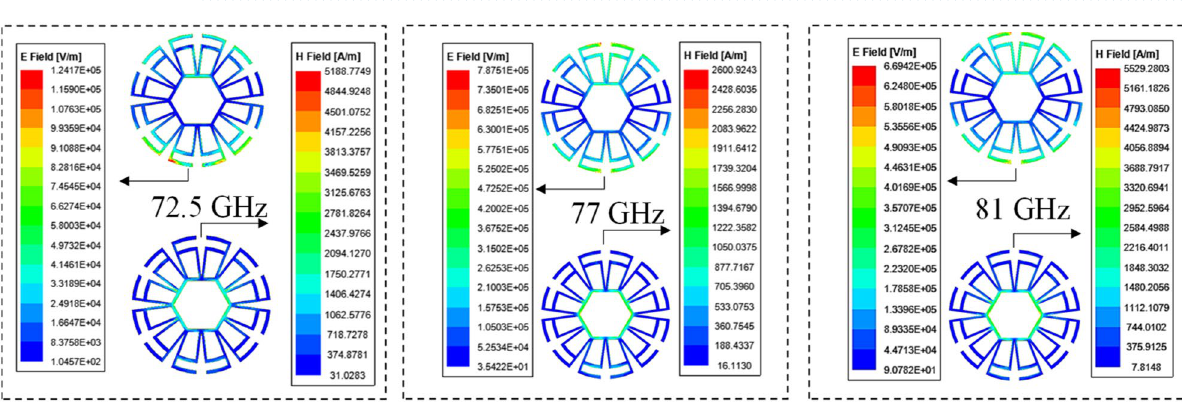
Figure 6. Electric (left side) and magnetic (right side) field magnitude at three frequency points: 72.5 GHz (lower), 77 GHz (central), and 81 GHz